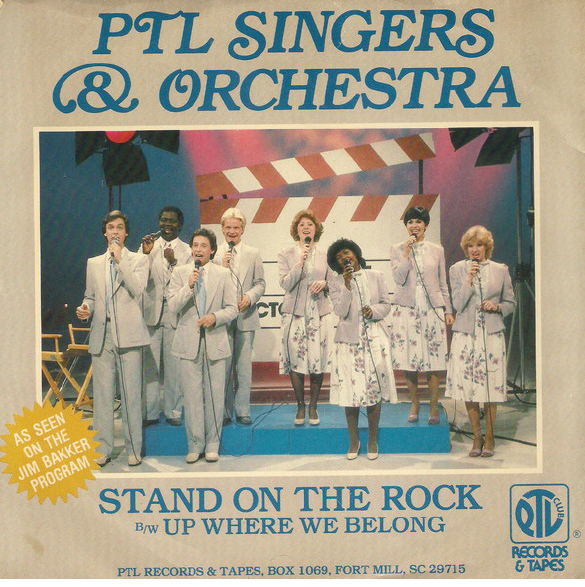
Figure 2. Winans on PTL Club record